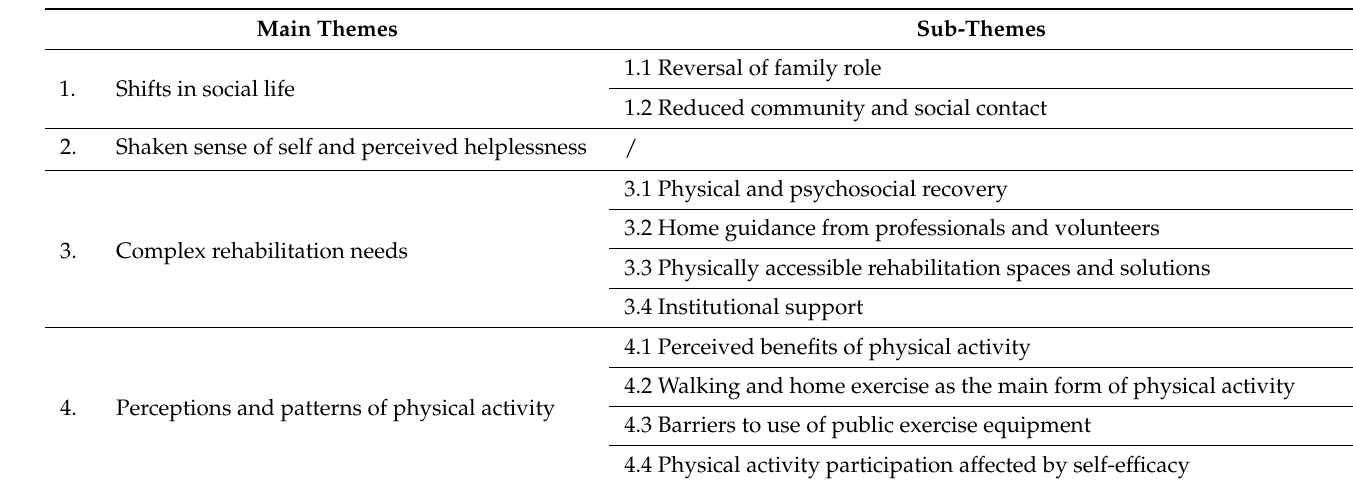
Table 3. Summary of themes emerging from the